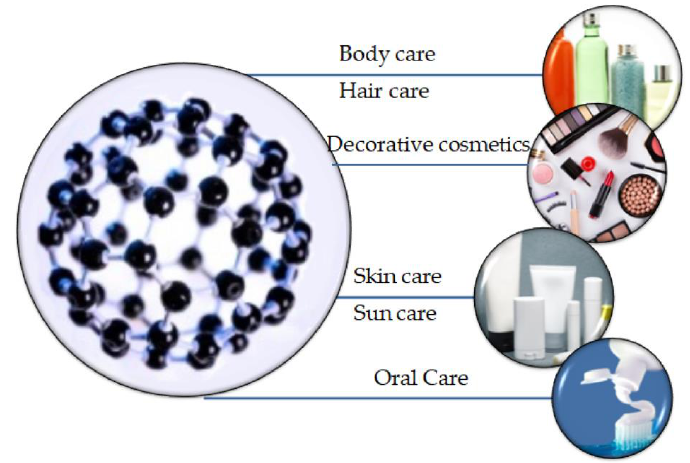
Figure 8. The applications of nanomaterials in the cosmetic field. Reprinted from an open access source [139].